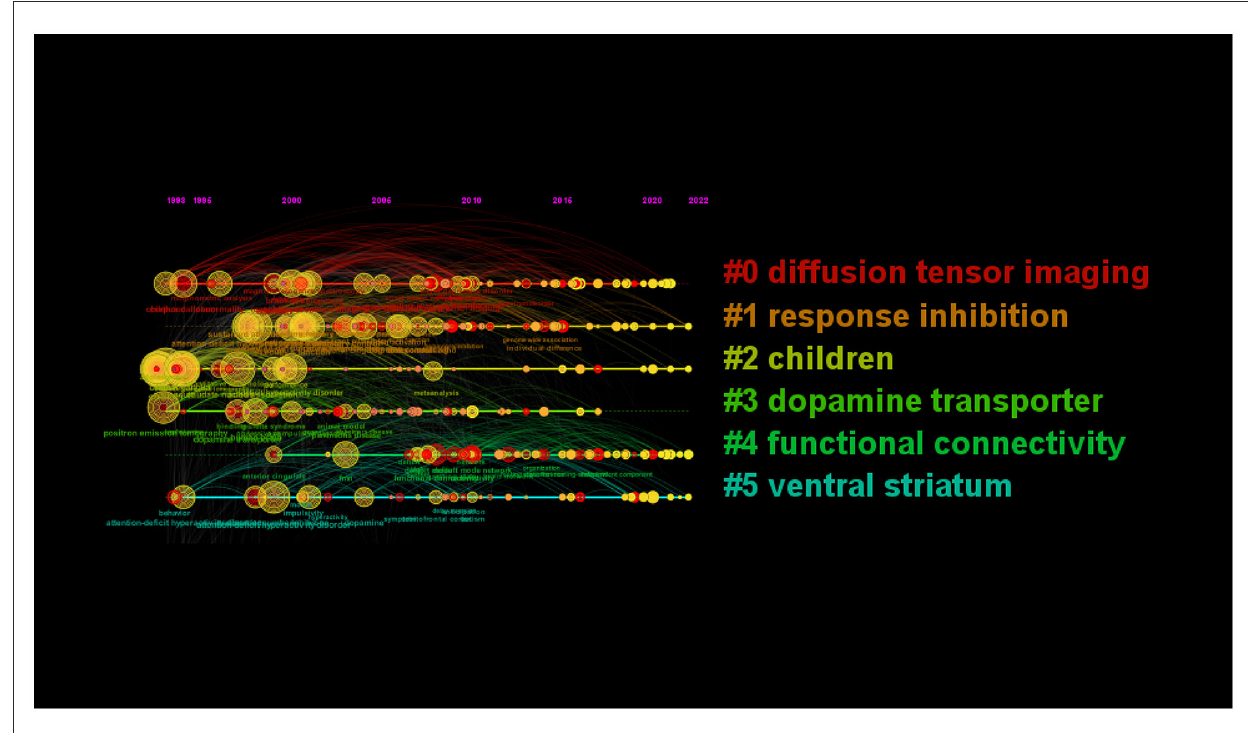
FIGURE8 Clustering map and timeline of keywords related to ADHD